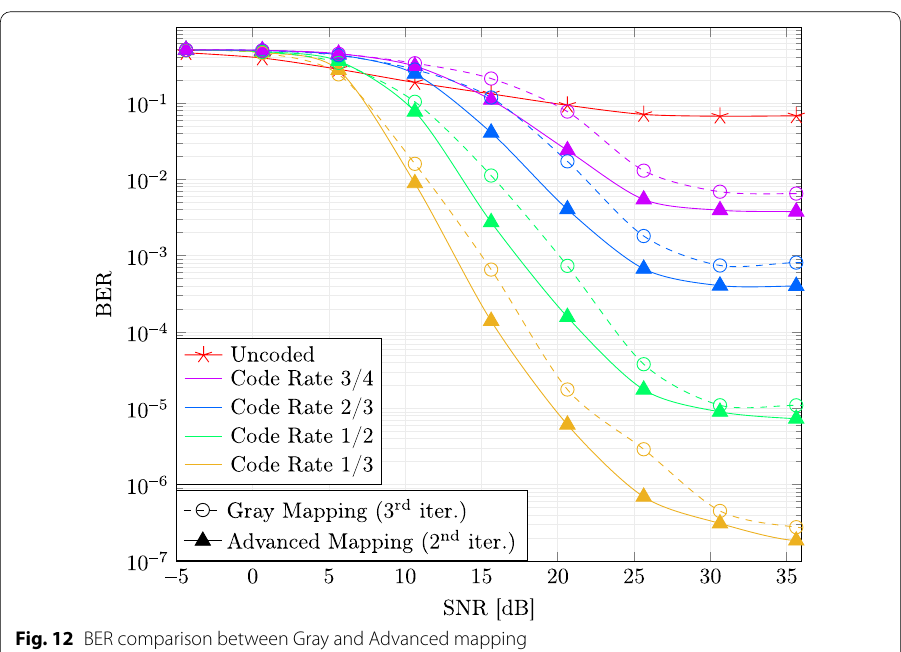
Fig. 12 BER comparison between Gray and Advanced mapping